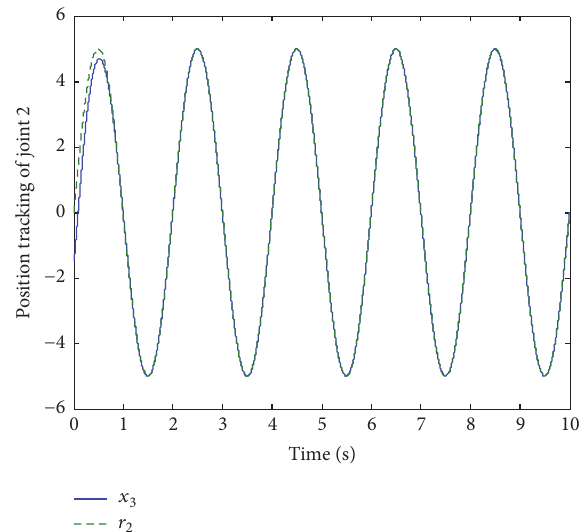
Figure 1: Actual value 𝑥 1 and tracking state of input signal 1.